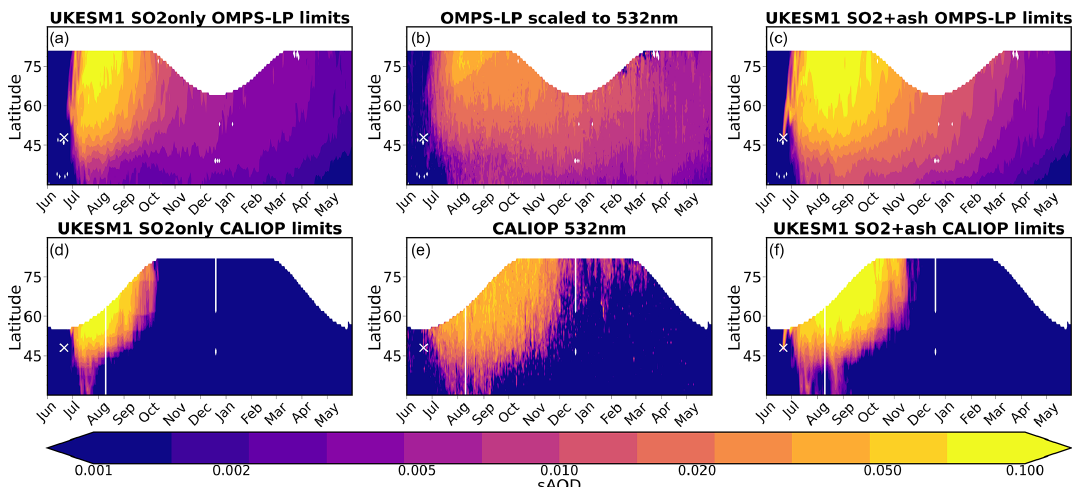
Figure 4. Latitude–time distribution of the zonally averaged sAOD from 30 to 90 ◦ N. (a) UKESM1 SO2only masked for OMPS-LP obser- vations, scaled from 550 to 532nm; (b) OMPS-LP observations scaled from 869 to 532nm; (c) UKESM1 SO2 + ash masked for OMPS-LP observations, scaled from 550 to 532nm; (d) UKESM1 SO2only masked for CALIOP observations, with sAOD calculated with values of aerosol extinction < 0 . 012km − 1 and the CALIOP minimum detection limit scaled to 532nm; (e) CALIOP observations at 532nm; and (f) UKESM1 SO2 + ash masked for CALIOP observations, with sAOD calculated with values of aerosol extinction < 0 . 012km − 1 and the CALIOP minimum detection limit scaled to 532nm. The location of Raikoke is marked with a white cross.